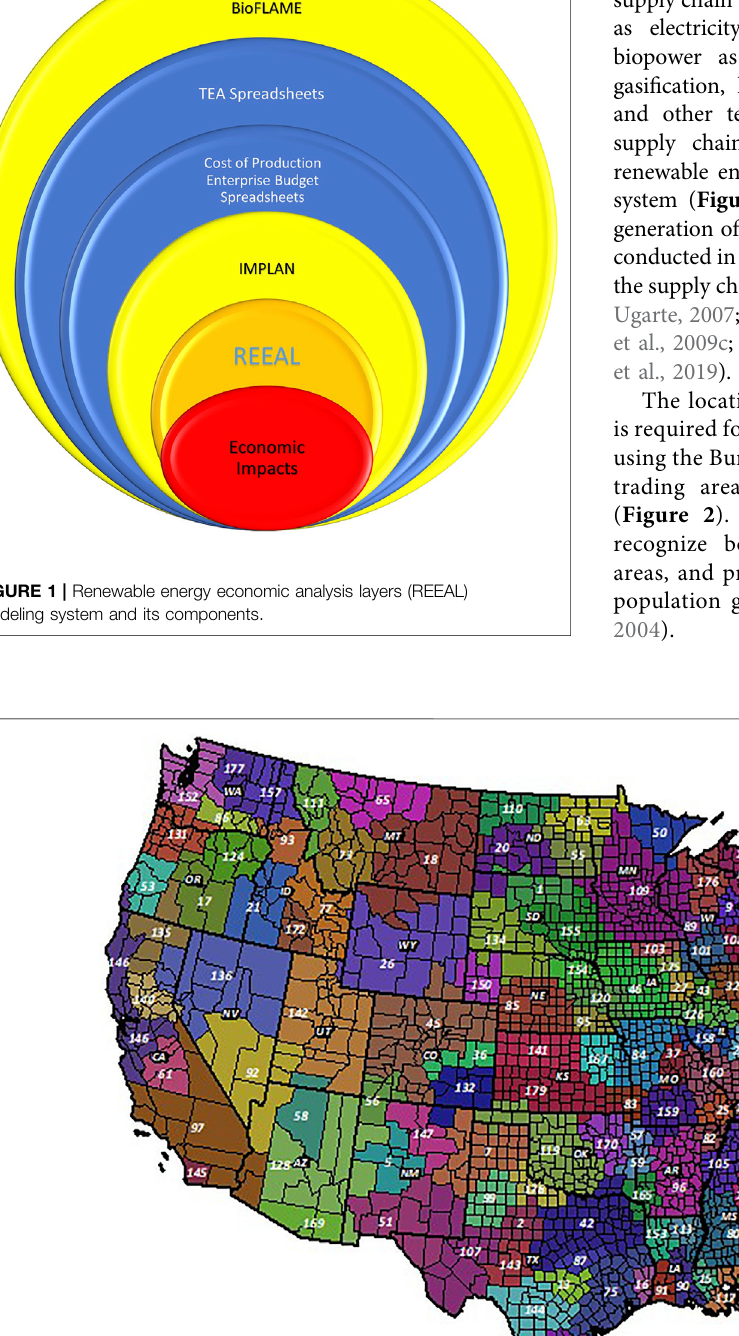
Frontiers in Energy Research |